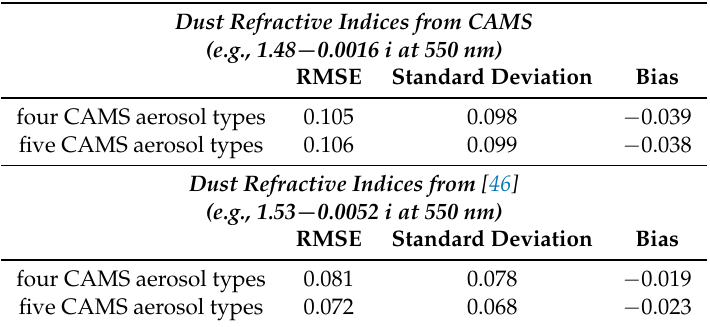
Table 7. Performances over arid sites for the stable cases, of aerosol optical thickness (AOT) at 550 nm estimated by the MACCS-ATCOR Joint Algorithm (MAJA) using two different sets of refractive indices for Dust. CAMS: Copernicus Atmosphere Monitoring Service. RMSE: root-mean-square